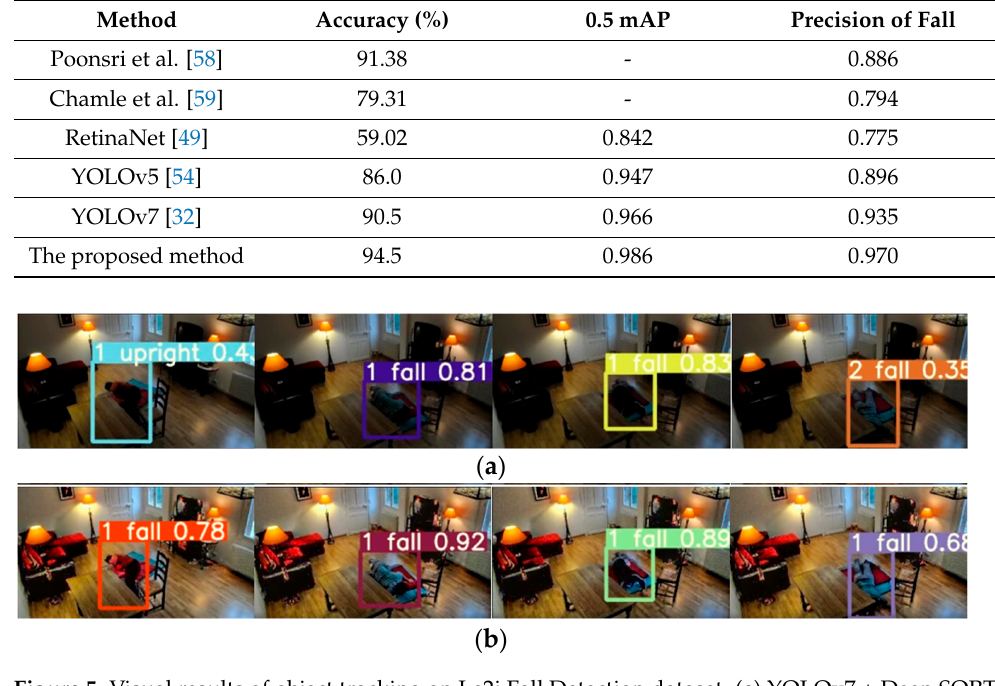
Table 5. p -Values of the McNemar’s significance test on UR-Fall dataset.